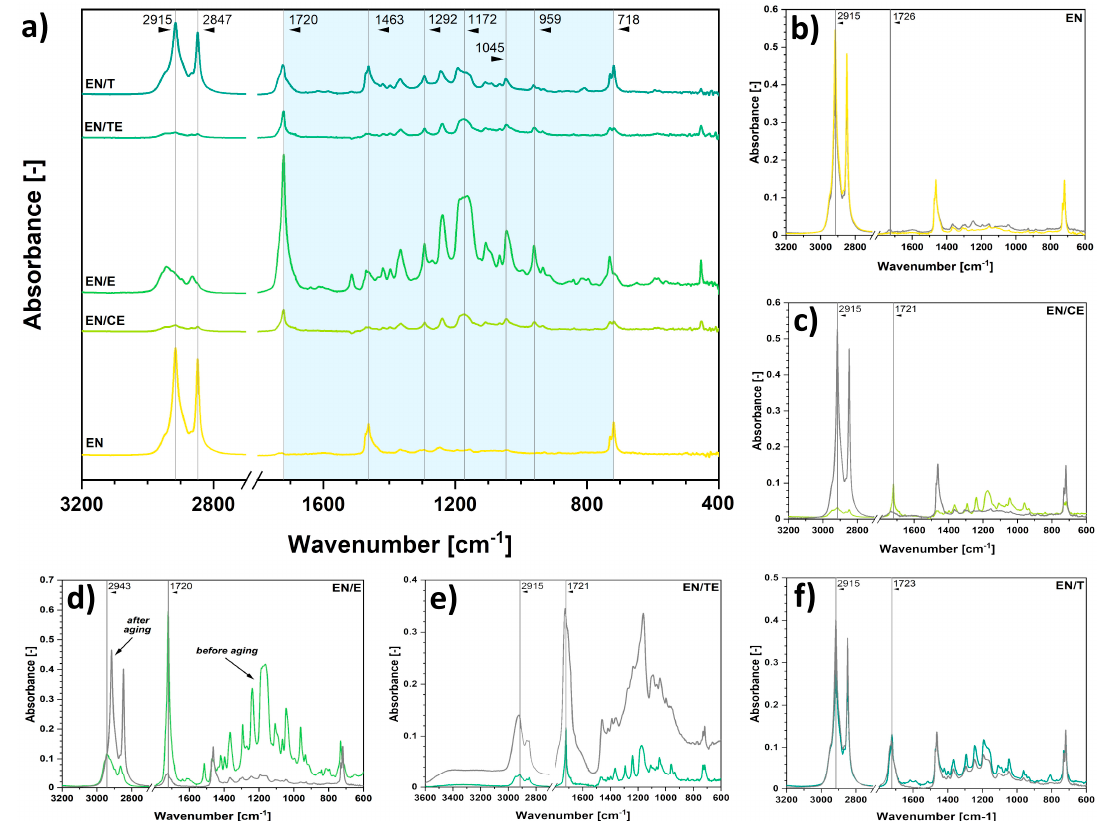
Figure 2. Fourier-transform infrared spectra for the impregnated samples of ethylene–norbornene (EN) copolymer ( a ) and representation of the changes observed after the aging process for: neat EN ( b ) and EN impregnated with clove extract ( c ), eugenol ( d ), thyme extract ( e ), thymol ( f ). Samples were subjected to 300 h of solar aging.